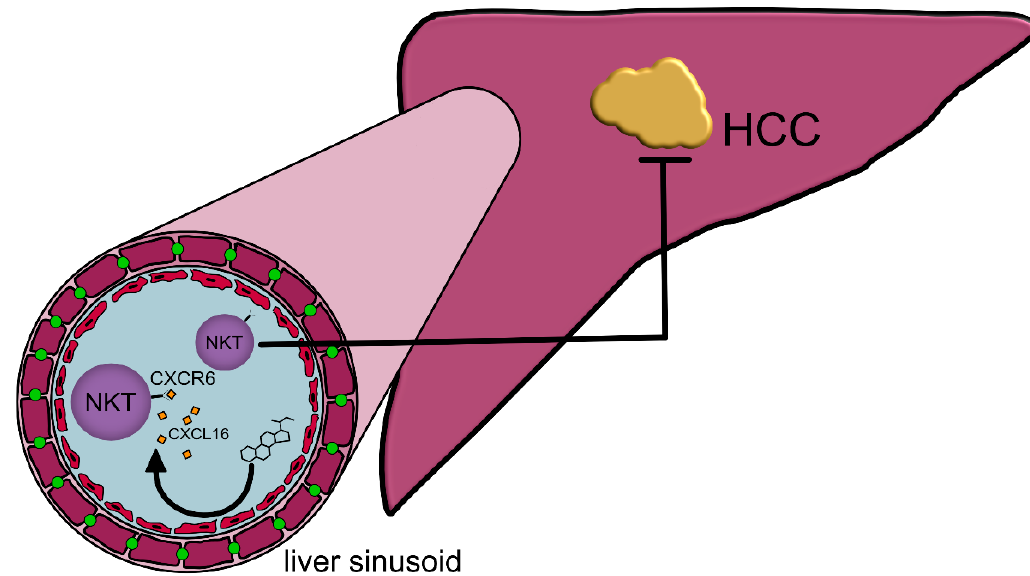
Figure 4. Inhibition of liver cell growth through natural killer T (NKT) cells. Chenodeoxycholic acid (CDCA) enhances the expression of CXCL16 on liver sinusoidal endothelial cells. Subsequently, CXCR6 + -NKT-cells accumulate in the liver and protect against hepatocellular carcinoma (HCC).